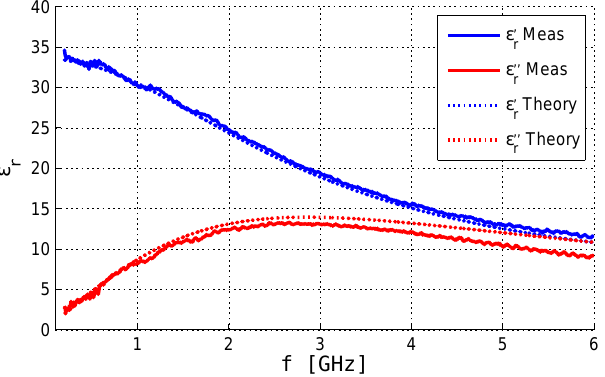
Figure A3. Theoretical and measured permittivity of